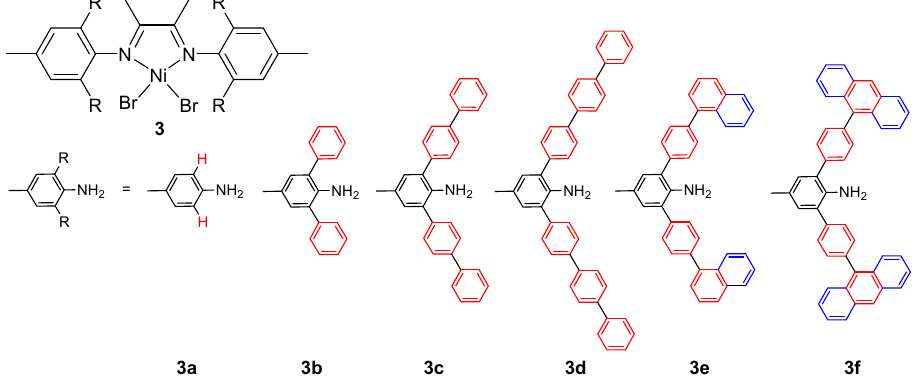
Figure 2. α -diimine nickel catalysts 3a – f with a bi-directional steric environment on the axial sites of the active species.